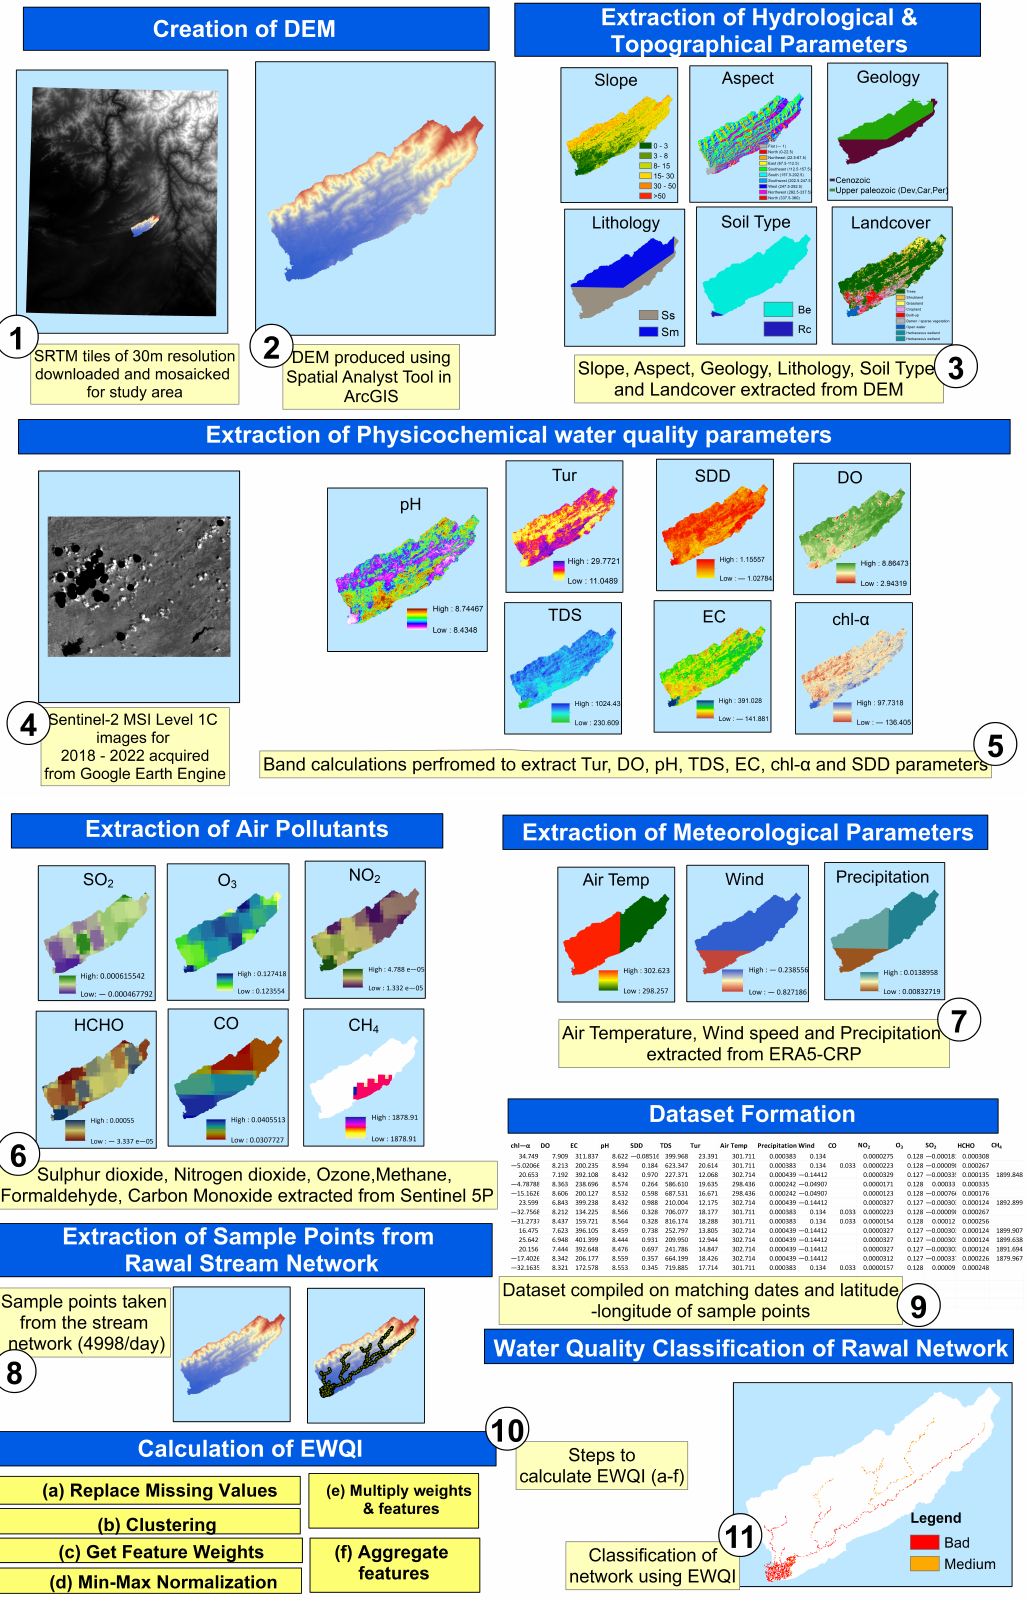
Figure 1. The steps involved in the extraction of multimodal parameters (1–7), extraction of samples (8), dataset formation (9), calculation and application of the EWQI for the study area